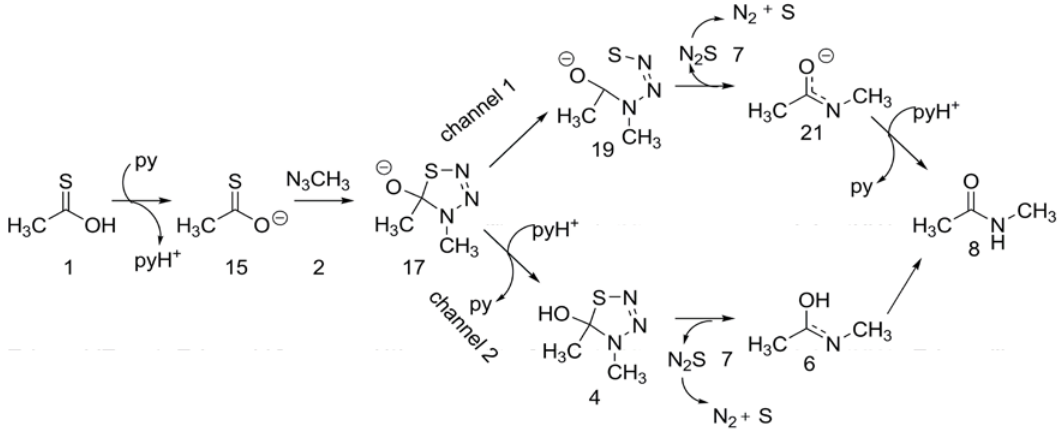
Table 2. Calculated reaction parameters for the reaction III a,b with R